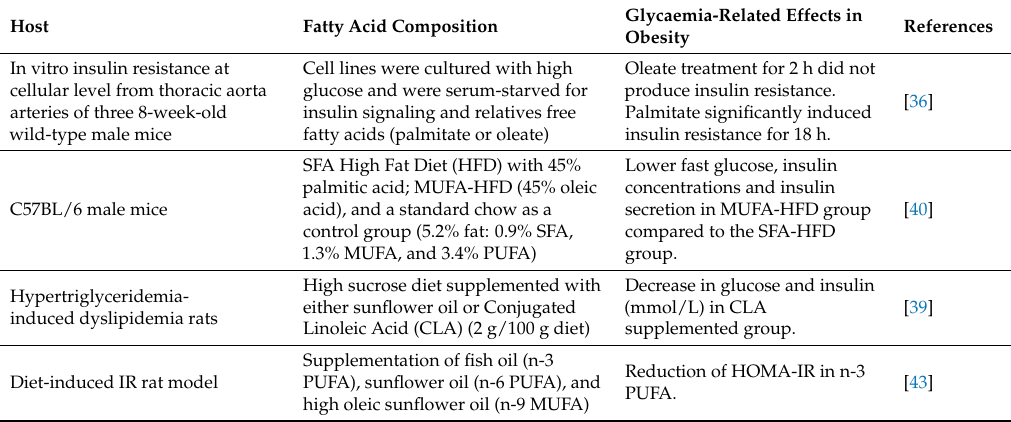
Table 2. Effects of different types of fatty acids on insulin resistance and associated comorbidities during in vivo and in vitro